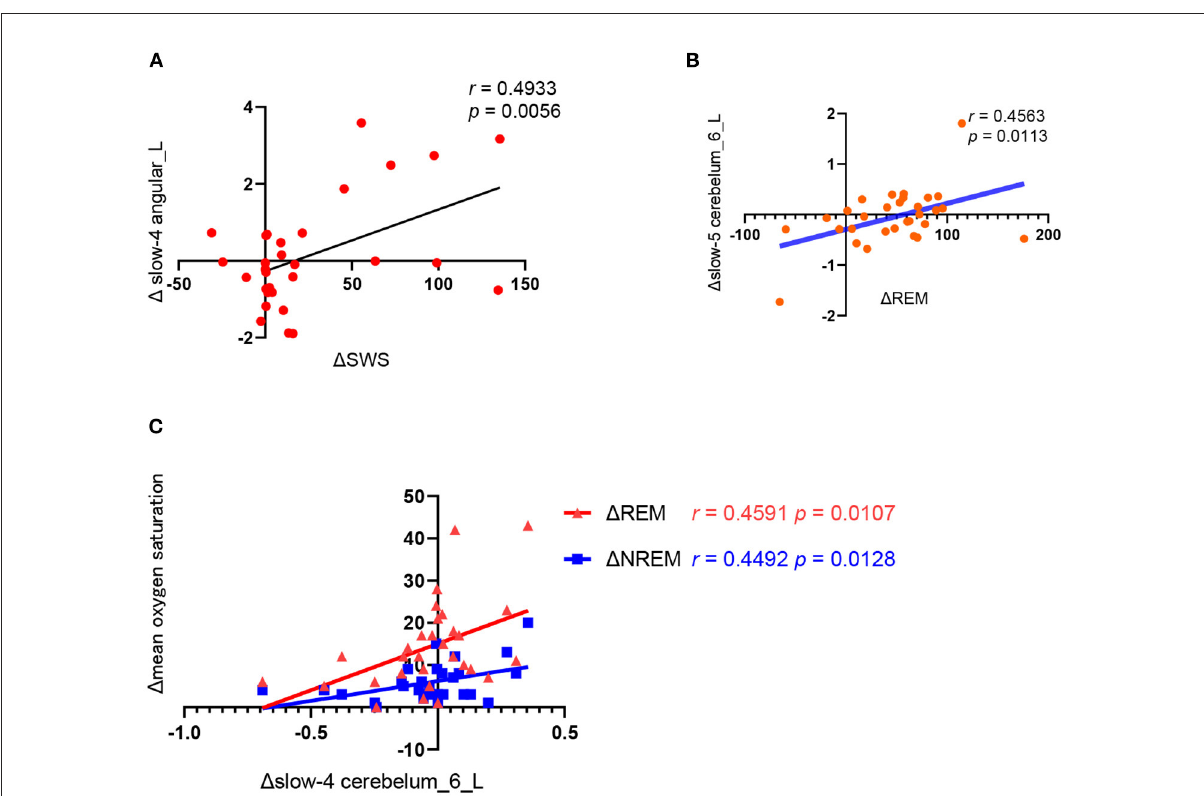
FIGURE3 Correlation analysis between the changes in polysomnography parameters and ALFF values before and after CPAP titration. (A) 1 SWS (the SWS time of the CPAP night minus baseline); 1 slow4 angular_L(the slow-4 ALFF in the angular_L of post-CPAP minus the pre-CPAP), (B) 1 REM (the REM time of the CPAP night minus baseline), 1 slow-5 cerebelum_6_L (the slow-5 ALFF in the cerebelum_6_L of post-CPAP minus the pre-CPAP). (C) . 1 slow-4 cerebelum_6_L (the slow-4 ALFF in the cerebelum_6_L of post-CPAP minus the pre-CPAP), 1 mean oxygen saturation (the mean oxygen saturation of REM or NREM of the CPAP night minus